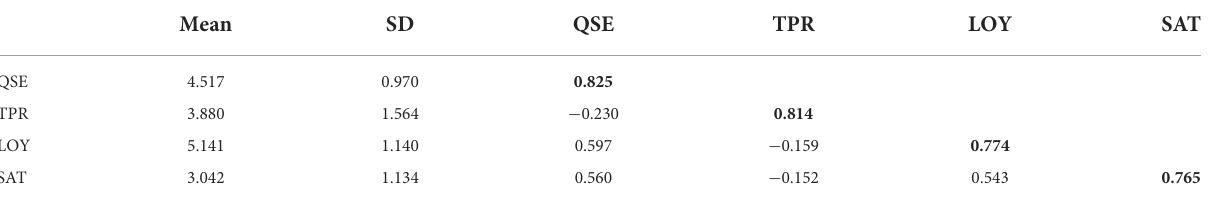
TABLE 4 Discriminate validity